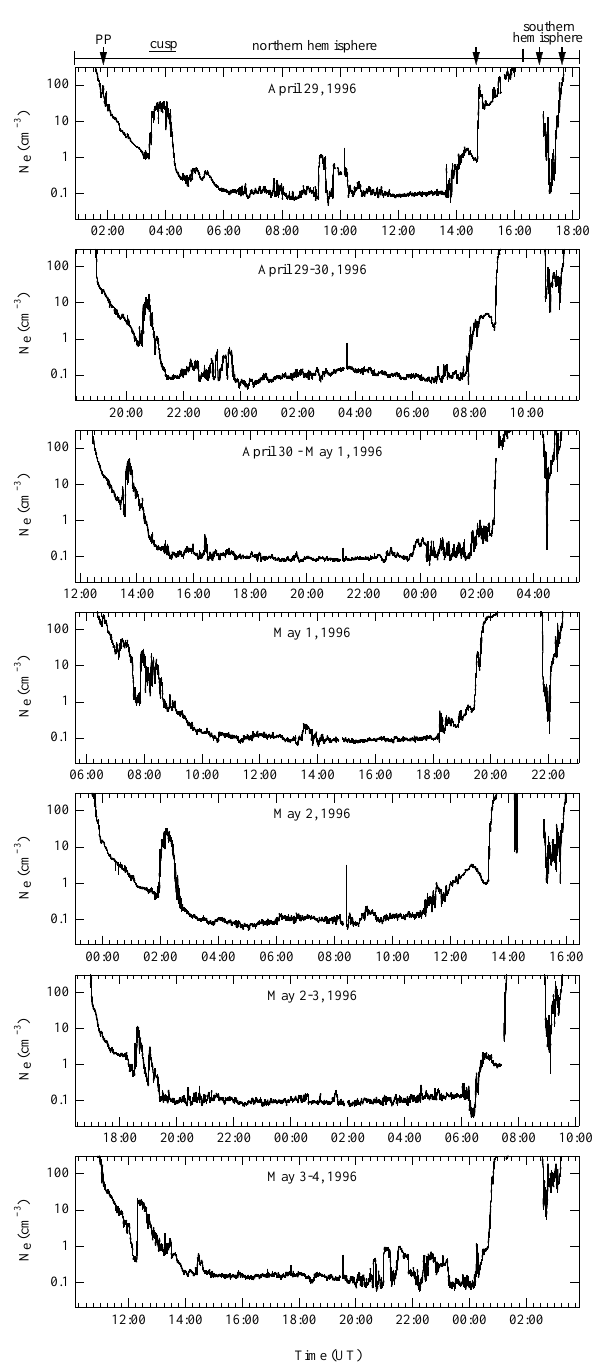
Fig. 2. Electron density variation on eight consecutive orbits of 29 April to 4 May 1996. The satellite’s orbital plane is near the noon- midnight meridian. Each panel presents a full orbit of data, from one perigee to the next